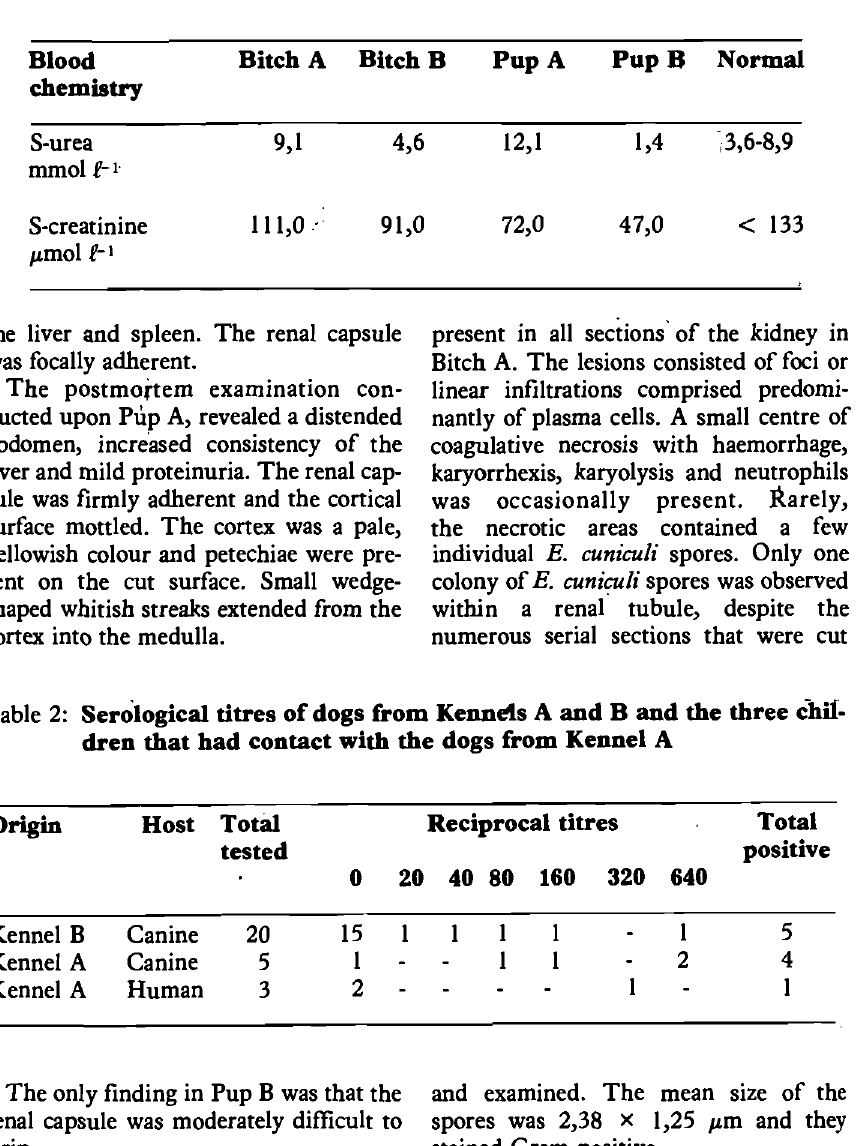
Table 1: Serum creatinine and urea concentrations of Bitch A and B and their respective pups